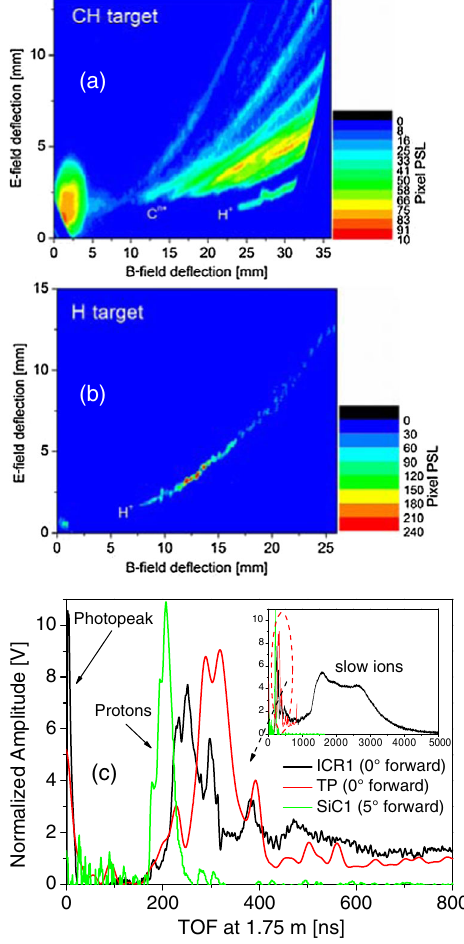
FIG. 4. (a) TP snapshot showing the typical signal from a plastic target (presence of protons, carbon, and other ions), where PSL is the photo-stimulated luminescence value. (b) TP snapshot showing the exclusive presence of protons for the H target (pure H plasma). (c) TOF spectra detected by ICR1, SiC1, and TP (recalculated at a distance of 1.75 m). The inset shows the slow ion TOF signal present up to 5 μ